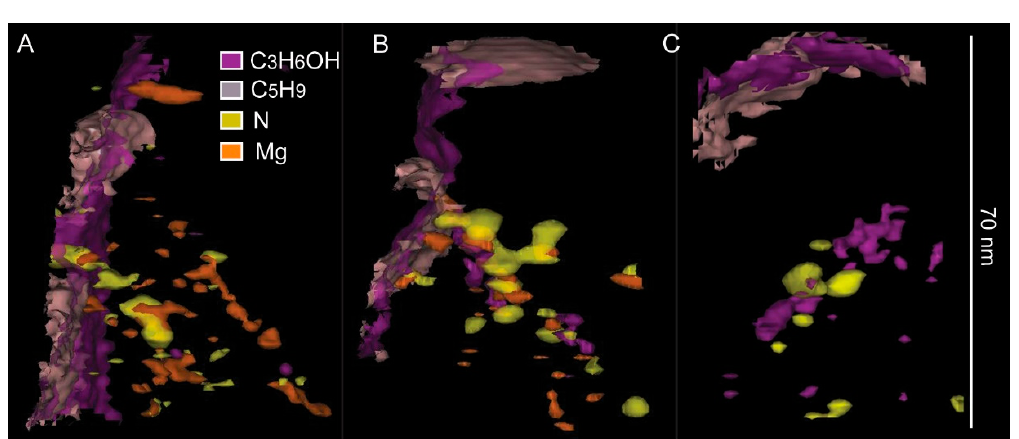
Figure 5. The 3D isosurface (surfaces of equal % at 1 σ level) reconstructions of selected tip specimens. ( A ) Isosurface reconstructions for the distribution of C 3 H 6 OH (at 11.12%), C 5 H 9 (at 25.93%), N compounds (at 2.44%), and Mg (0.47%) in tip M13 (W7). ( B ) Isosurface reconstructions for the distribution of C 3 H 6 OH (at 11.12%), C 5 H 9. (at 16.35%), N compounds (at 2.44%), and Mg (0.47%) in tip M20 (W7). ( C ) Isosurface reconstructions for the distribution of C 3 H 6 OH (at 11.47%), C 5 H 9 (at 13.05%), and N compounds (at 5.62%) in tip M3 (W8).